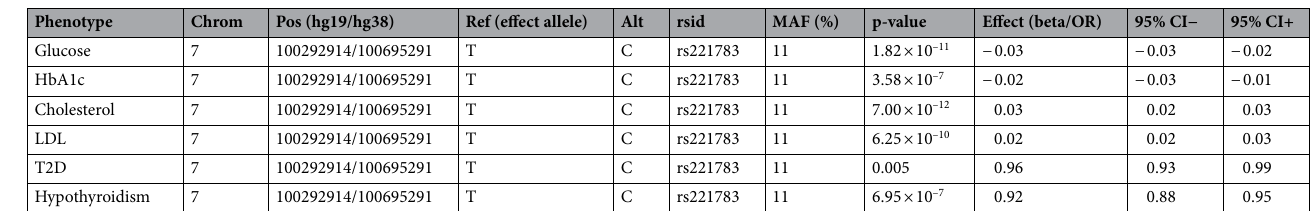
Table 6. Common variant associations at the GIGYF1 locus. Associations for the array-typed variant rs221783. For quantitative traits the effect is shown in standard deviations (beta) and for diagnoses as an odds ratio (OR). MAF minor allele